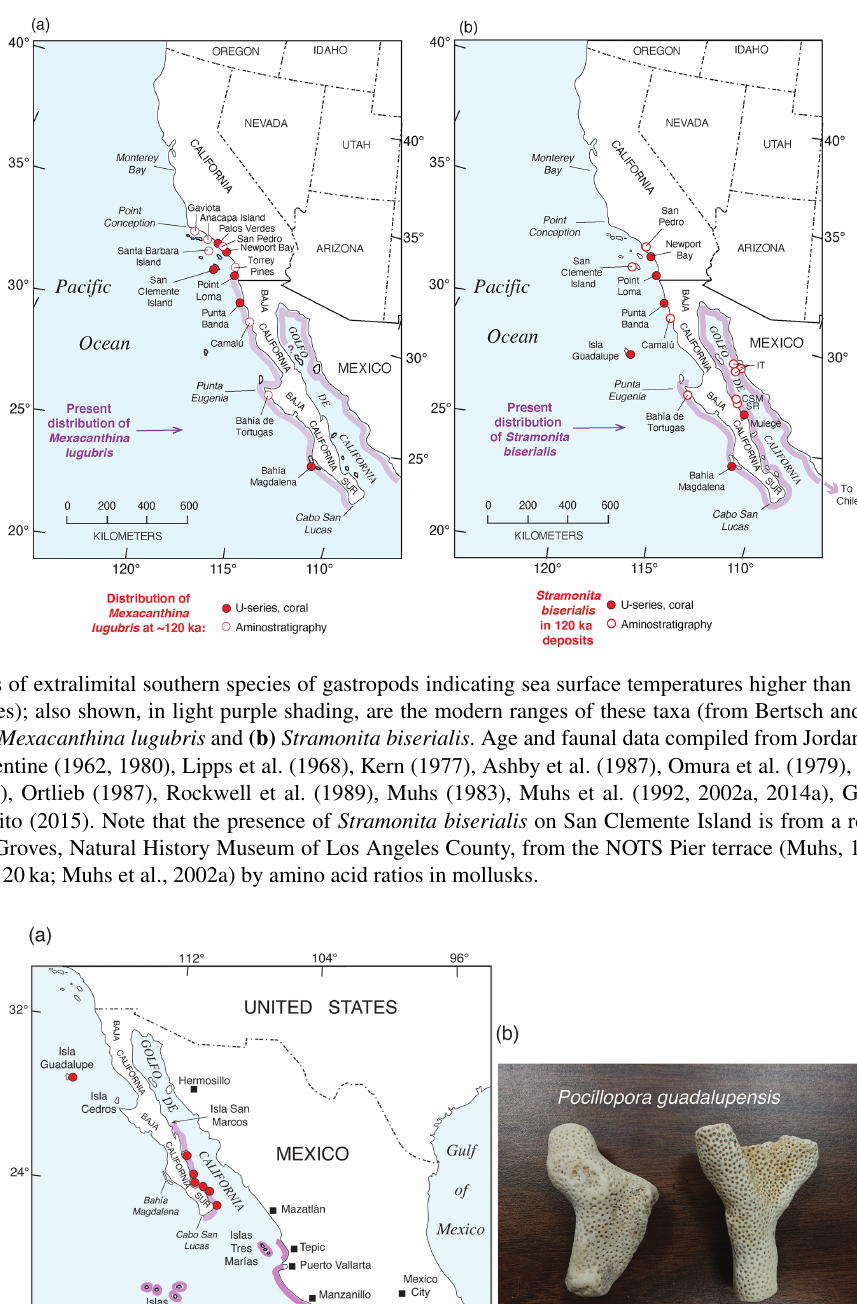
https://doi.org/10.5194/essd-14-1271-2022 Earth Syst. Sci. Data, 14, 1271–1330,